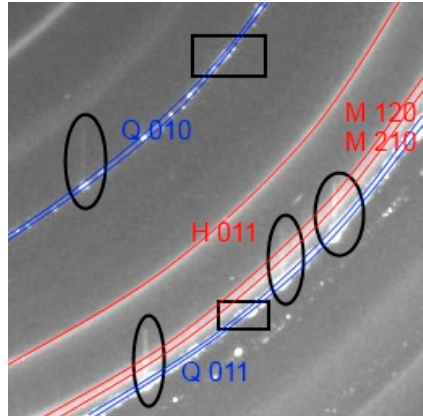
Figure 1. Cropped view of the 2D WAXS pattern from a geopolymer sample. The circled annotations on the image show the pixel overflow in the columns where a large quartz (Q) crystal saturated the detector, overflowing into adjacent pixels. This effect was reduced by applying a masking process to remove saturated pixels. The square annotations show the quartz peaks where it is clear there is a distribution of quartz d-spacings. Note, the hematite (H 011) and mullite (M 120 and M 210) peaks are smooth continuous rings, indicating the crystallite size is small compared to the diffraction information volume, hence, there are thousands to millions of crystallites.